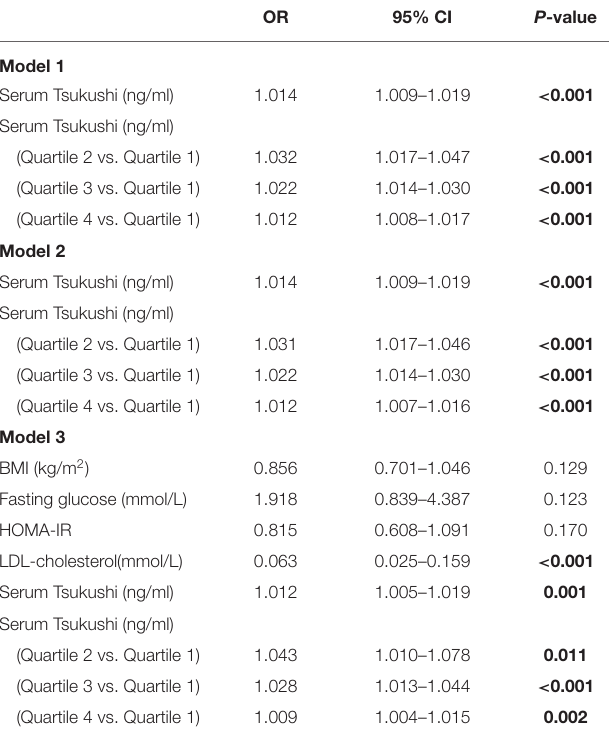
TABLE 5 | Effect of thionamide treatment on serum Tsukushi levels in hyperthyroid patients. Variables